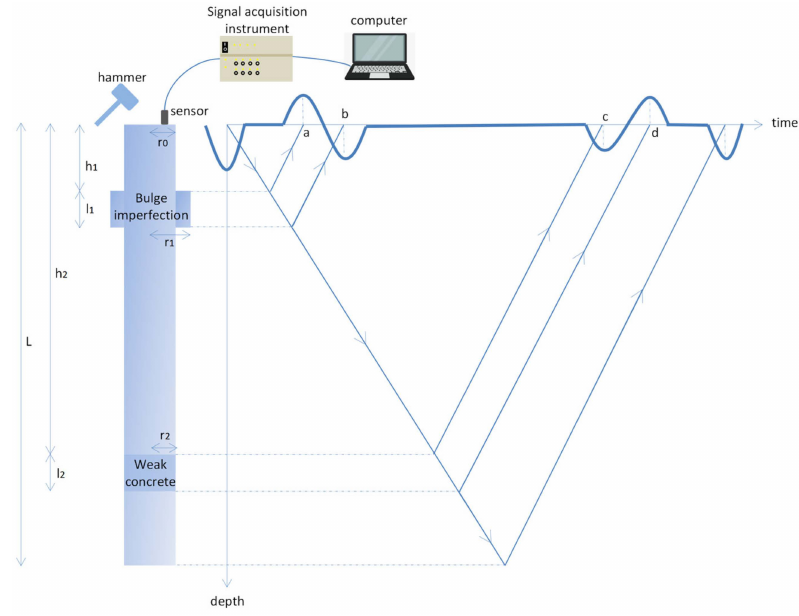
Figure 1. Low-strain pile integrity test